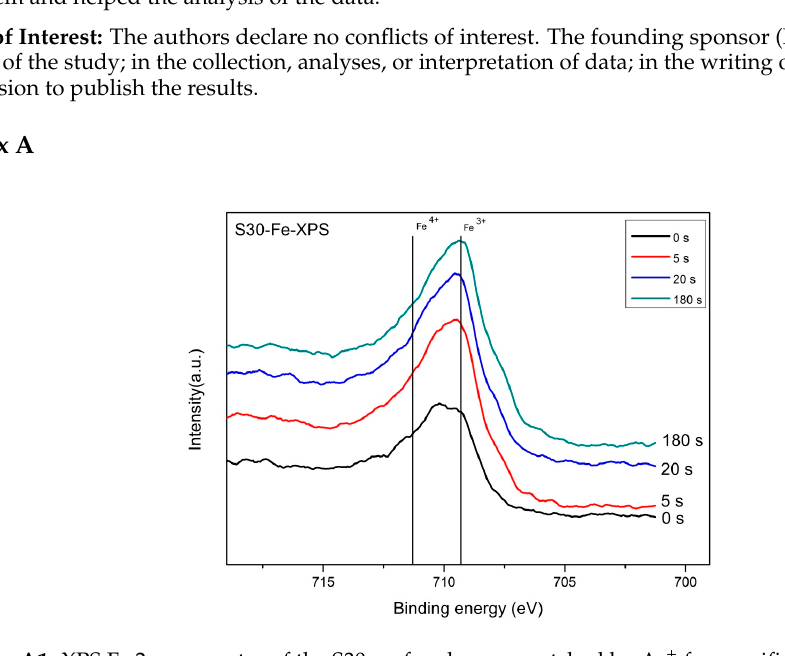
Figure A1. XPS Fe 2p 3/2 spectra of the S30 surface been pre-etched by Ar + for specified period, where 0 s means no Ar + etching.